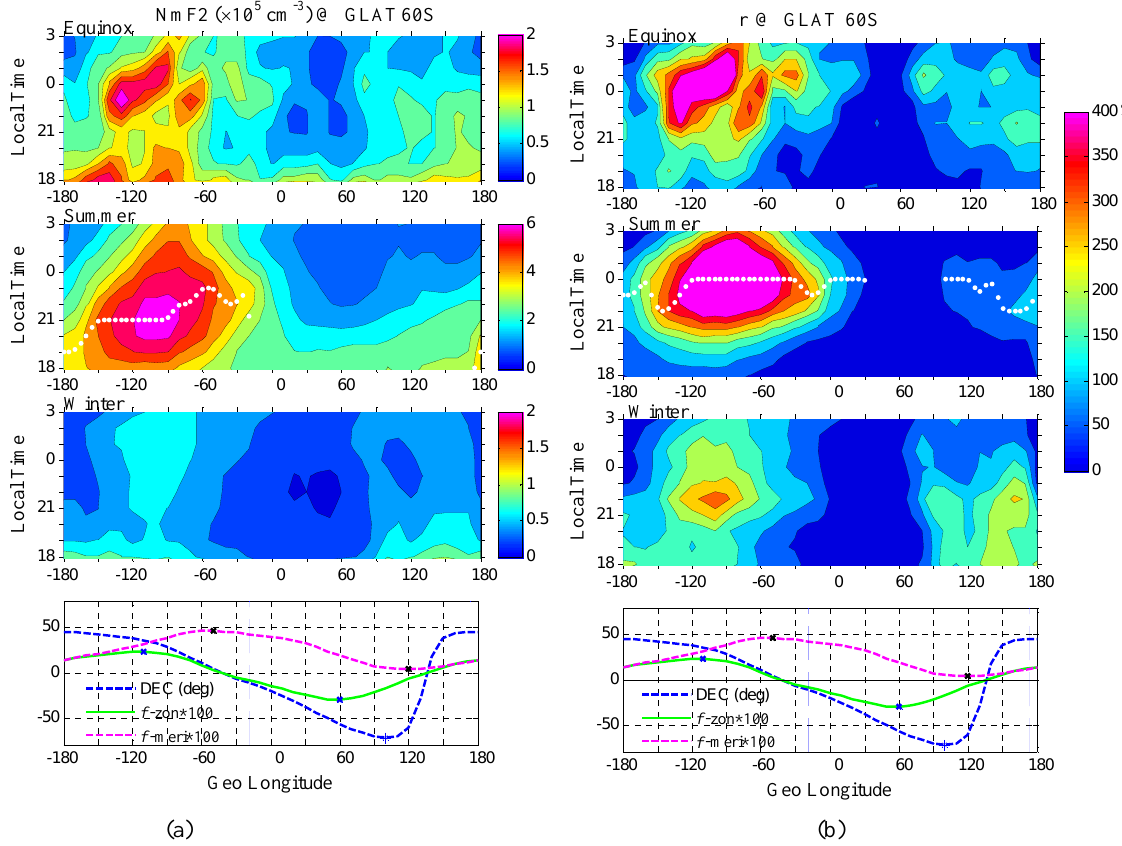
Figure 2. Similar with Figure 1, but for the longitudinal variations of the electron density at 60°S. Fig. 2. Similar to Fig. 1 but for the longitudinal variations of the electron density at 60 ◦